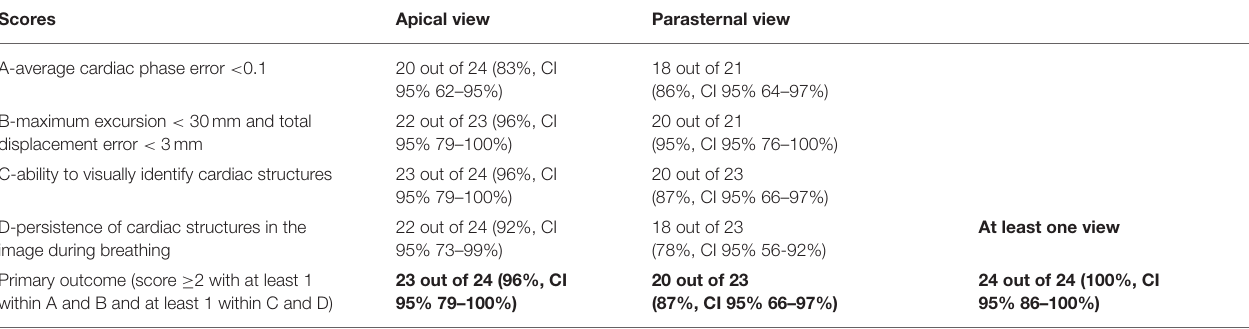
TABLE 2 | Multi-parametric score results and primary outcome. Scores Apical